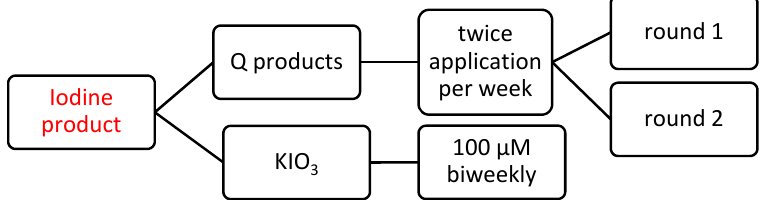
Figure 1. Graphical Scheme of Q products treatment application frequency.